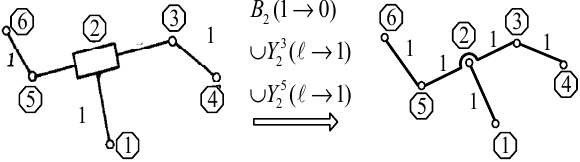
Figure 1. Translocation operation.